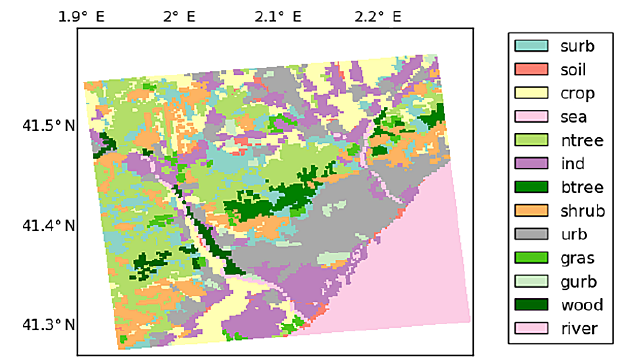
Figure 2. Distribution of the land-use types used in the UrbClim simulations, which were derived from the CORINE